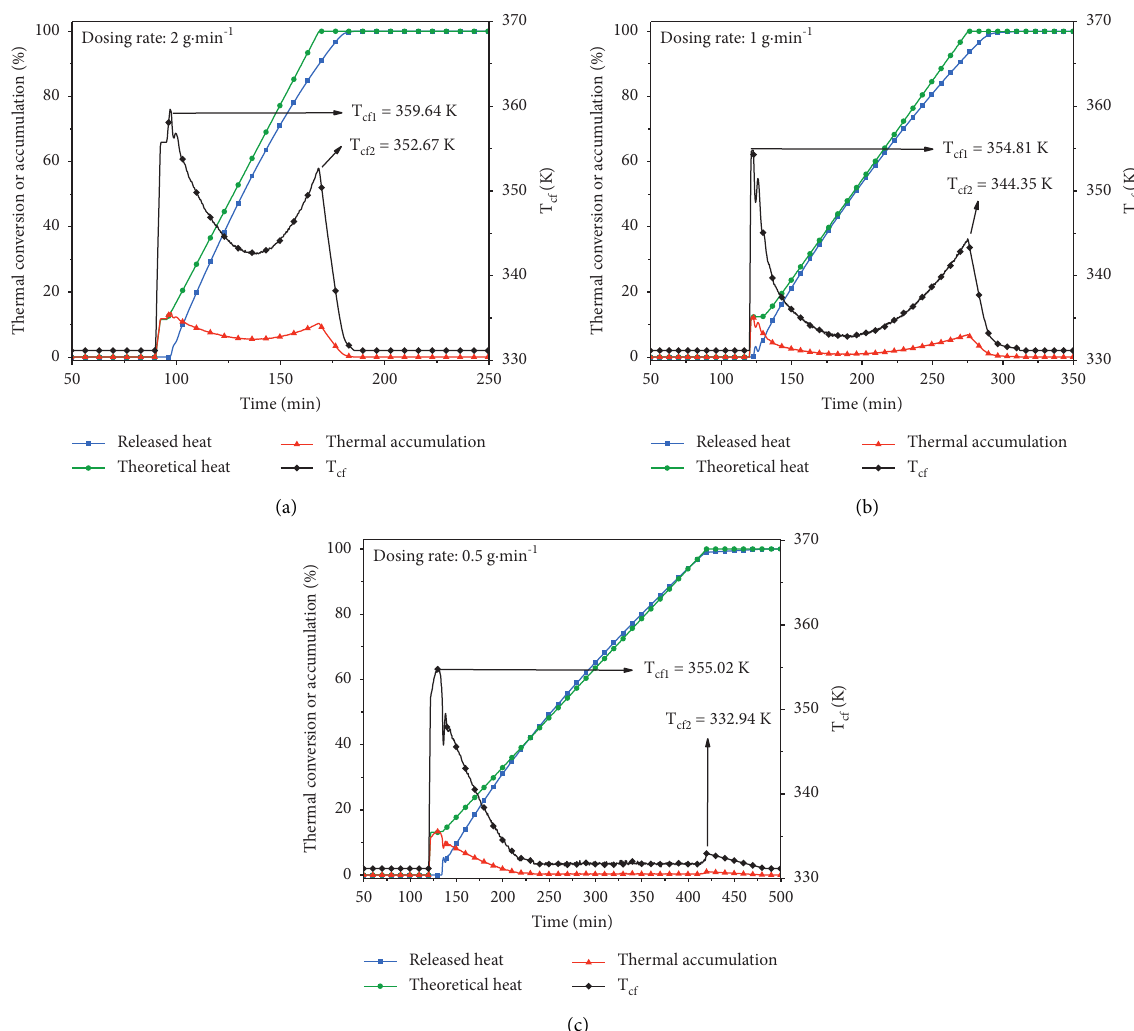
Figure 5: Thermal release, thermal accumulation, dosing of p -bromotoluene, and T cf curves for synthesis of Grignard reagent. (a) Dosing rate of 2.0g · min − 1 . (b) Dosing rate of 1.0g · min − 1 . (c) Dosing rate of 0.5g · min − 1 . T cf 1 is the maximum temperature in the induction period, and T cf 2 is the maximum temperature during the dosing Figure 9. It can be seen that T of Grignard reagent was D24 488.20 K.